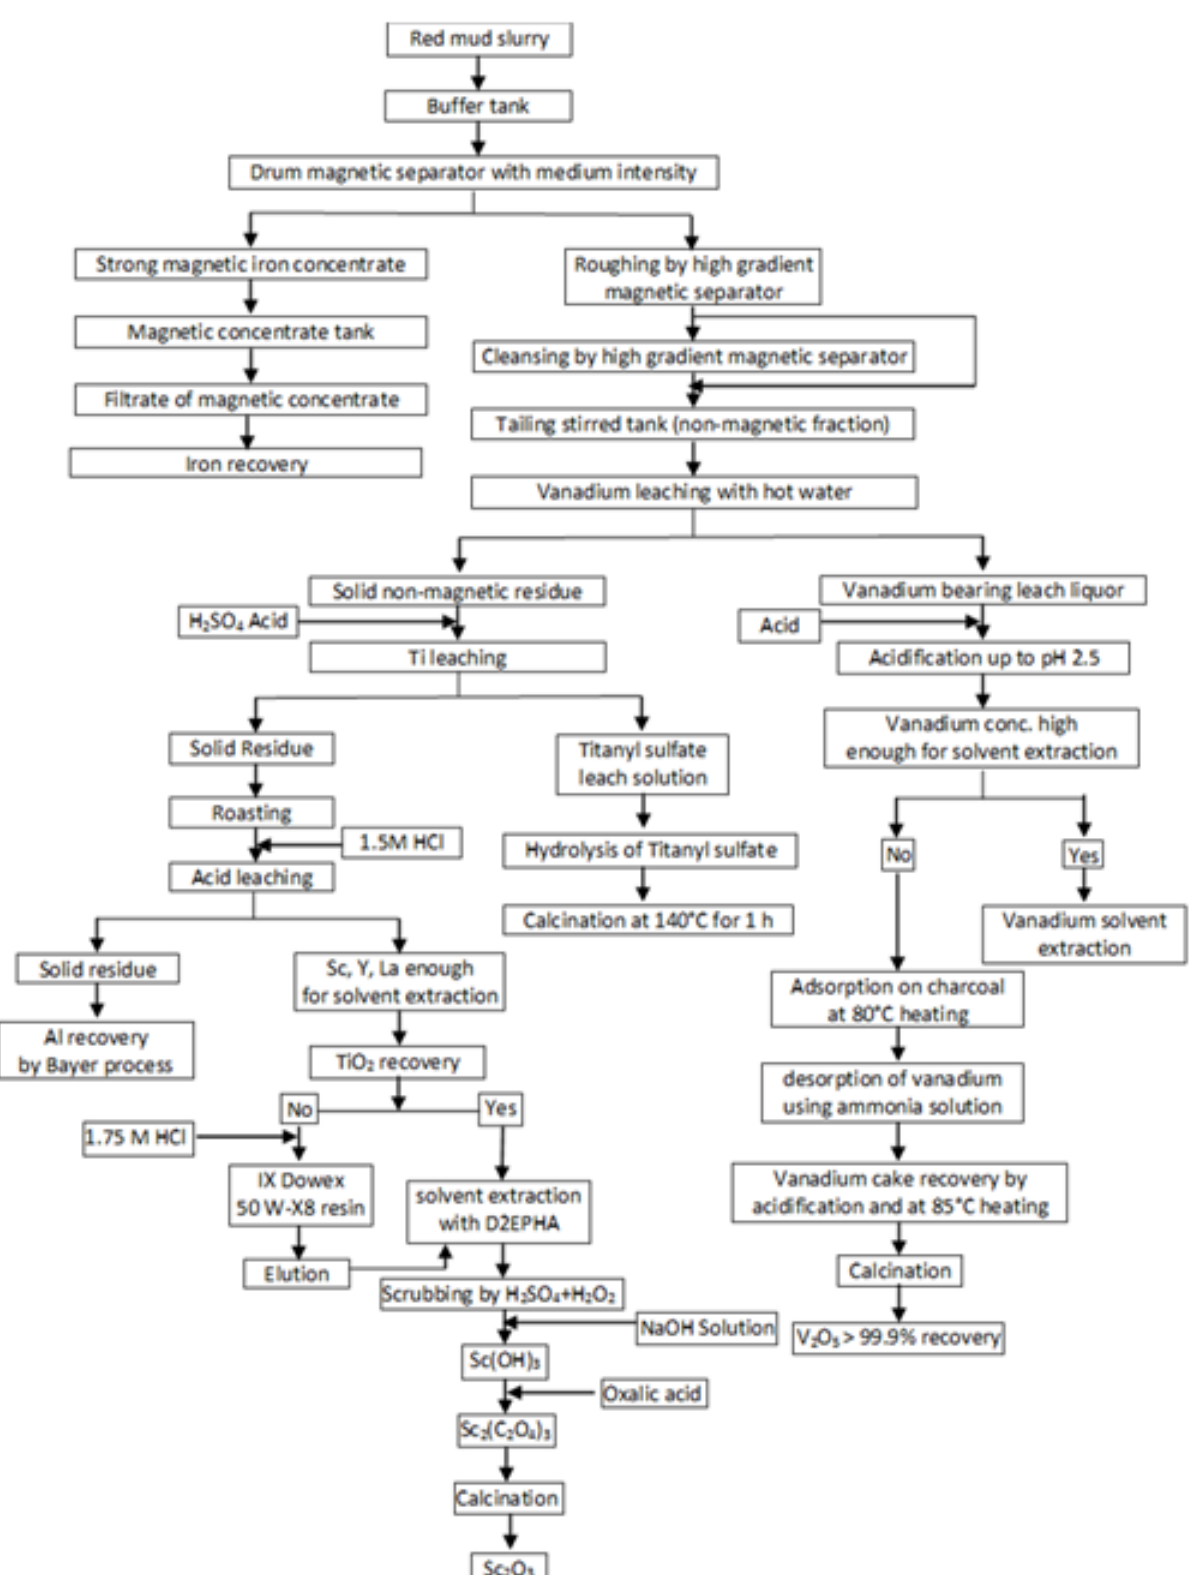
Figure 4. A conceptual route for recovery of valuable elements from red mud. Adopted from [15].